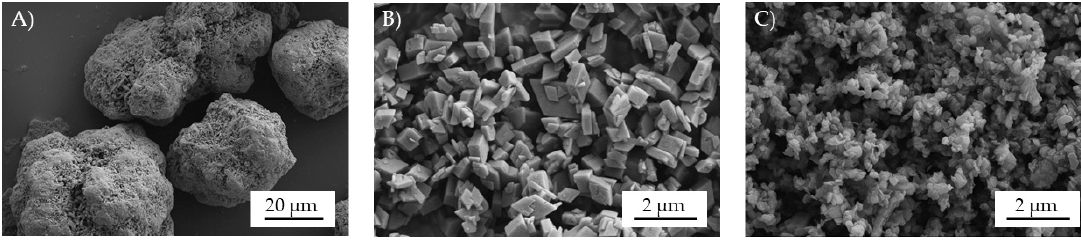
Figure 1. SEM images of the used flame retardant powder particels, ( A ) AlPi (Exolit OP 1240), ( B ) boehmite powder Actilox B60, and ( C ) boehmite powder Actilox 200SM.